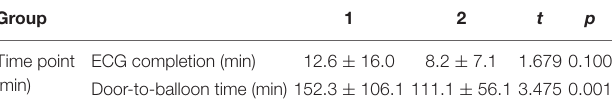
TABLE 3 | Comparison of two time points between two groups. Group